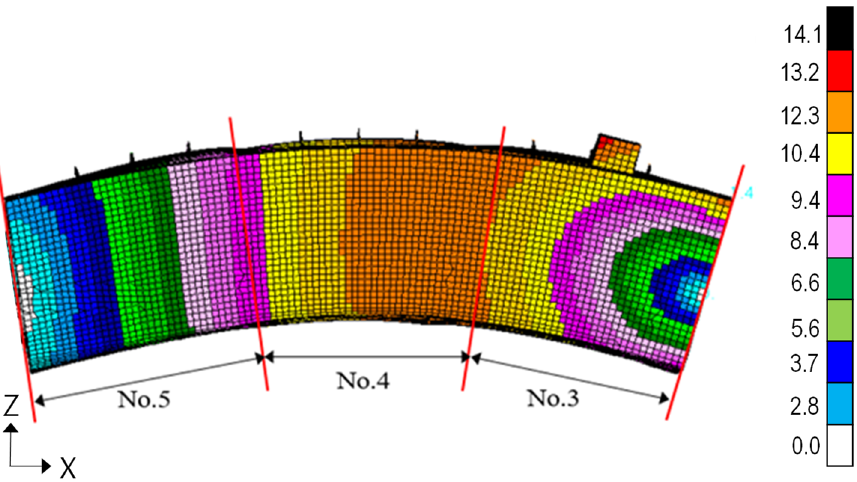
Figure 10. Deformed shape and displacement of three cargo hold models under hogging conditions (unit: mm).